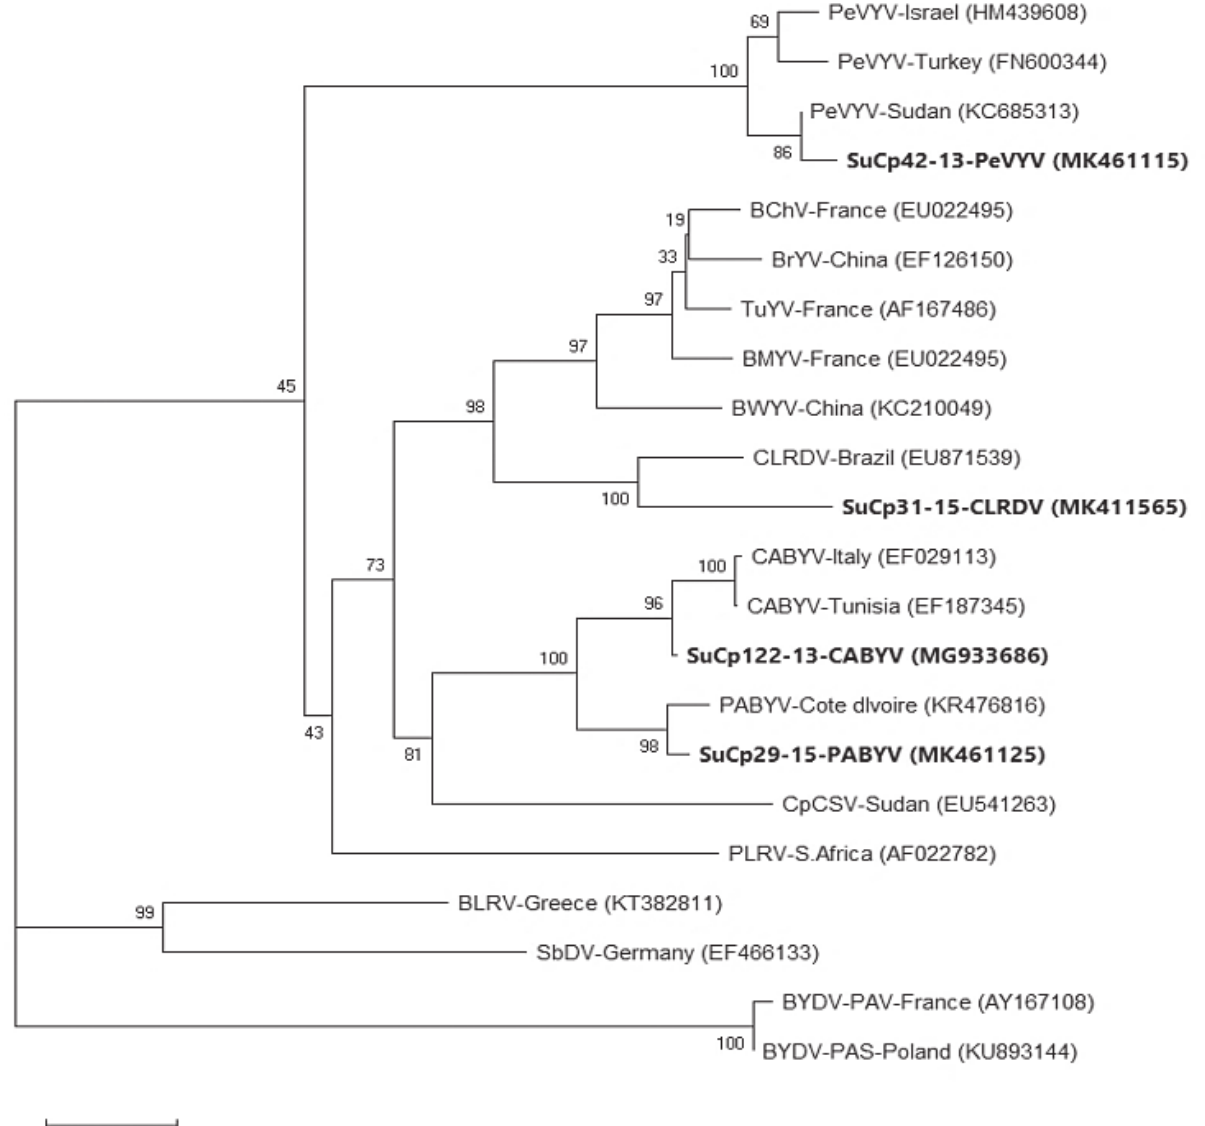
Figure 3. Dendrogram showing the phylogenetic relationships of the predicted partial coat protein amino acid sequences from AS3/ Pol3870F fragment of new detected distinct luteovirid isolates with those of other luteovirids from the database. The scale bar represents 0.050 divergence of the Hasegawa-Kishino-Yano dissimilarity index. Bootstrap analysis was carried out with 1000 replicates of the starting tree. Bootstrap values are shown in each branch. Database accession numbers of the luteovirid sequences and the virus acronyms used are presented in Table